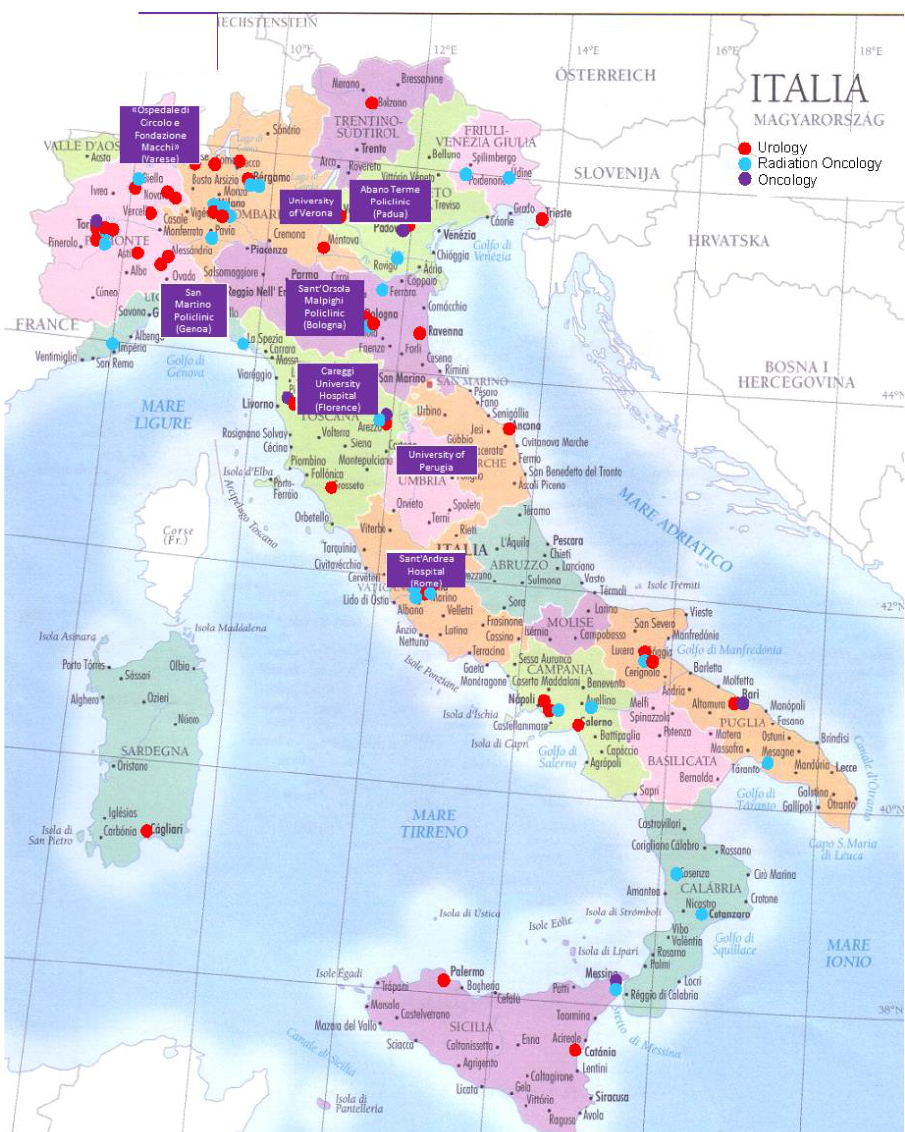
Figure 1. Centers participating in the Pros-IT CNR study (red, blue or purple dots) and centers participating in the Pros-IT2 study (purple rectangles).